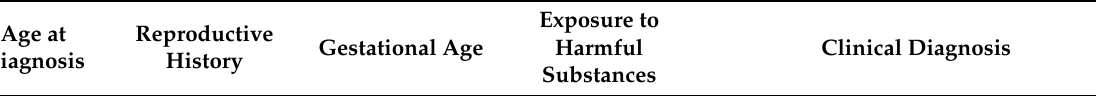
Table 1. Clinical features for pregnant women with fetal diagnosis of